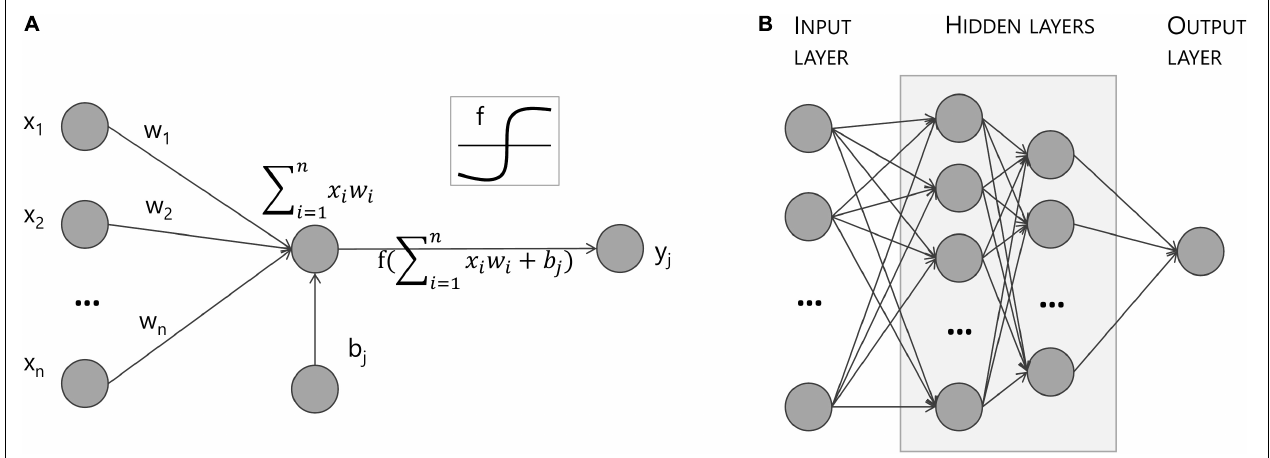
FIGURE 3 | Schematic representation of the signal-flow of a perceptron (A) and a Multi-Layered Perceptron (B) . The inputs are connected to a neuron and each connection is associated with a weight “w.” The output is produced by combining the inputs and weights and adding the neuron’s bias “b j ” before going through a sigmoid activation function “f.” A Multi-Layered Perceptron is composed of multiple neurons in hidden layers combined in the same manner to produce a single